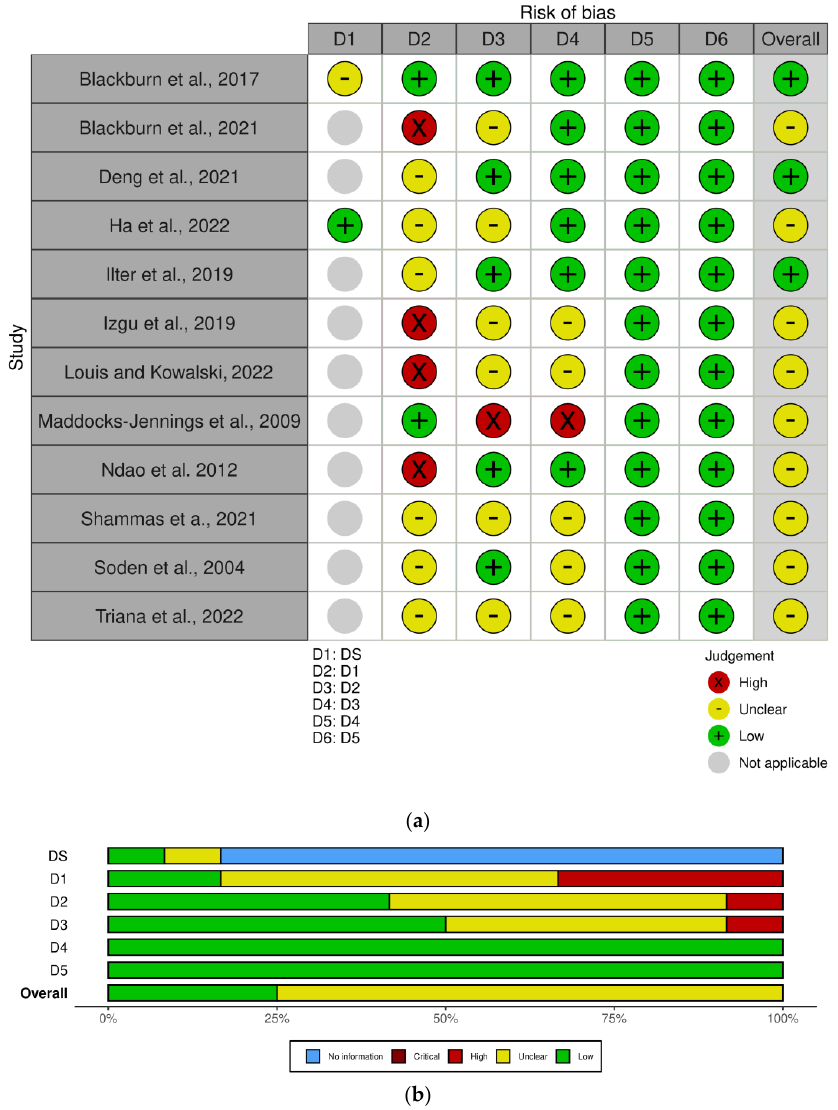
Figure 2. Risk of Bias assessment as traffic-light plot ( a ) and weighted bar plots ( b ). The visualization of the risk of bias assessment is produced with the Cochrane robvis visualization tool [49,71 – 82], and evaluated according to the revised Cochrane risk of bias tool RoB2 for randomized clinical trials and the Risk Of Bias In Non-randomized Studies — of Interventions (ROBINS-I) tool for studies not